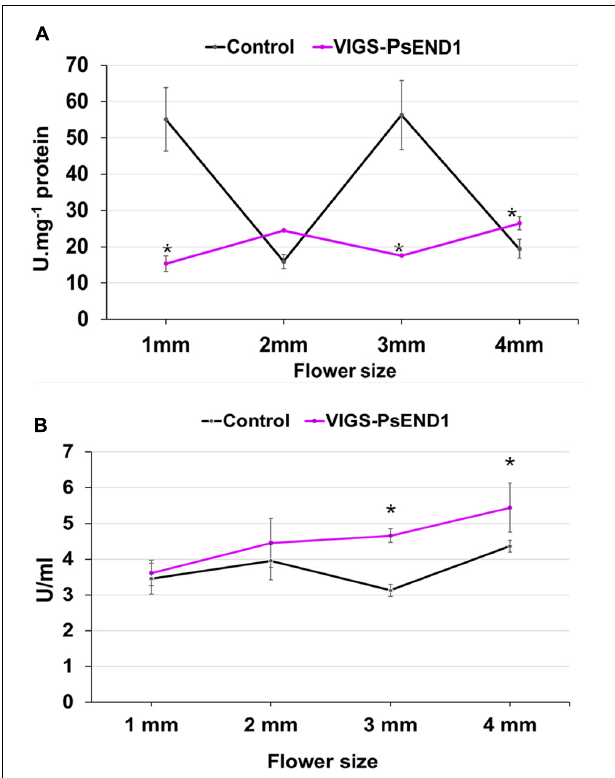
FIGURE 4 | Superoxide dismutase and peroxidase activity in transgenic pea plants. (A) SOD activity in control and VIGS- PsEND1 flowers at different developmental stages. SOD activity is significantly reduced in the VIGS- PsEND1 flowers. (B) Peroxidase activity in control and VIGS-PsEND1 flowers at different developmental stages. At stages 3 and 4 mm, peroxidase activity increases in the VIGS- PsEND1 plants compared to the control. * p ≤ 0.05, ** p ≤ 0.01, *** p ≤